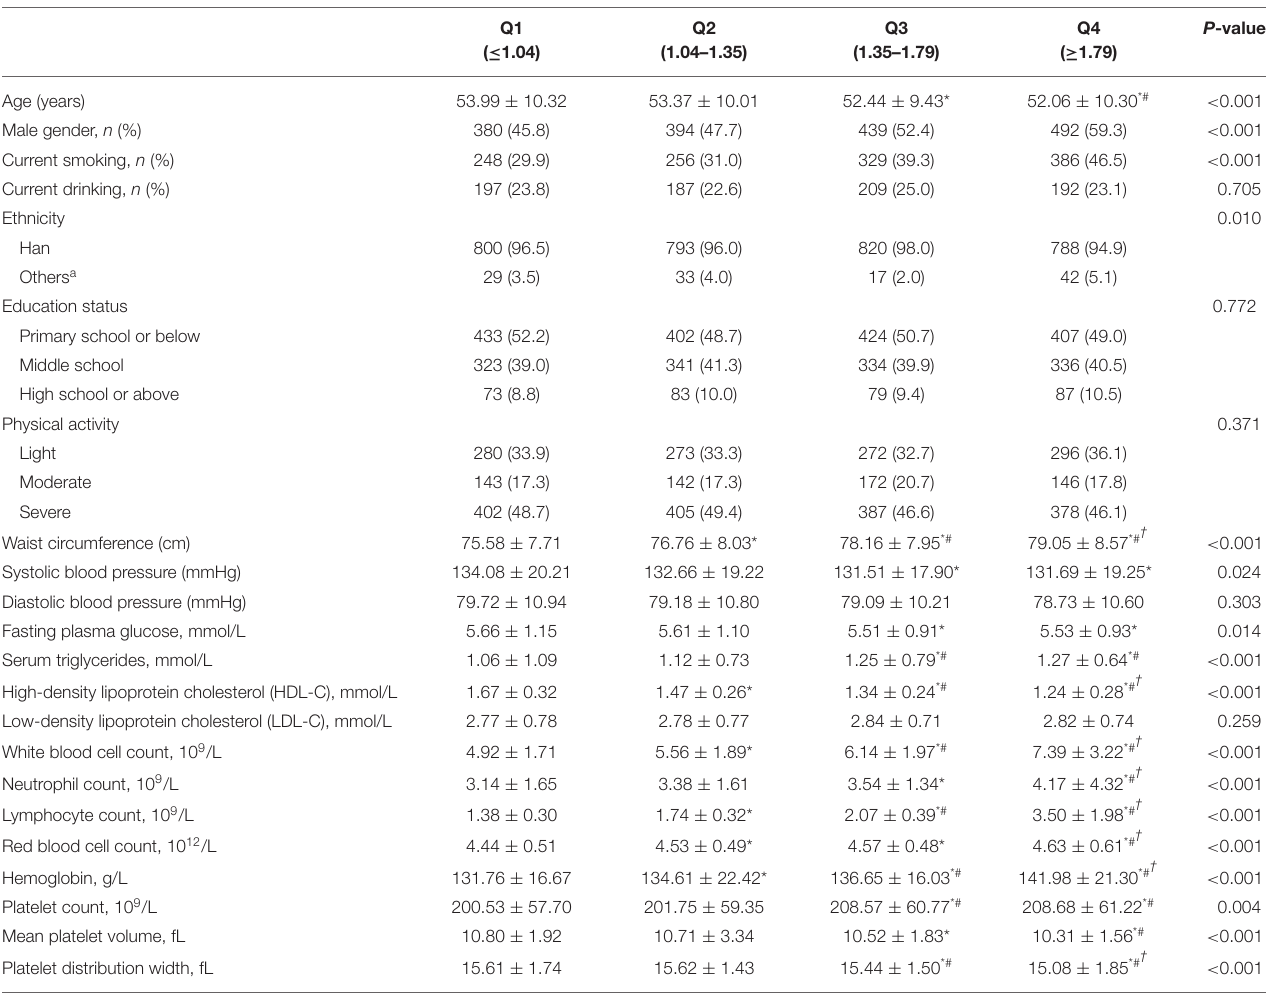
TABLE 1 | Characters of subjects according to quartile of lymphocyte to high density lipoprotein